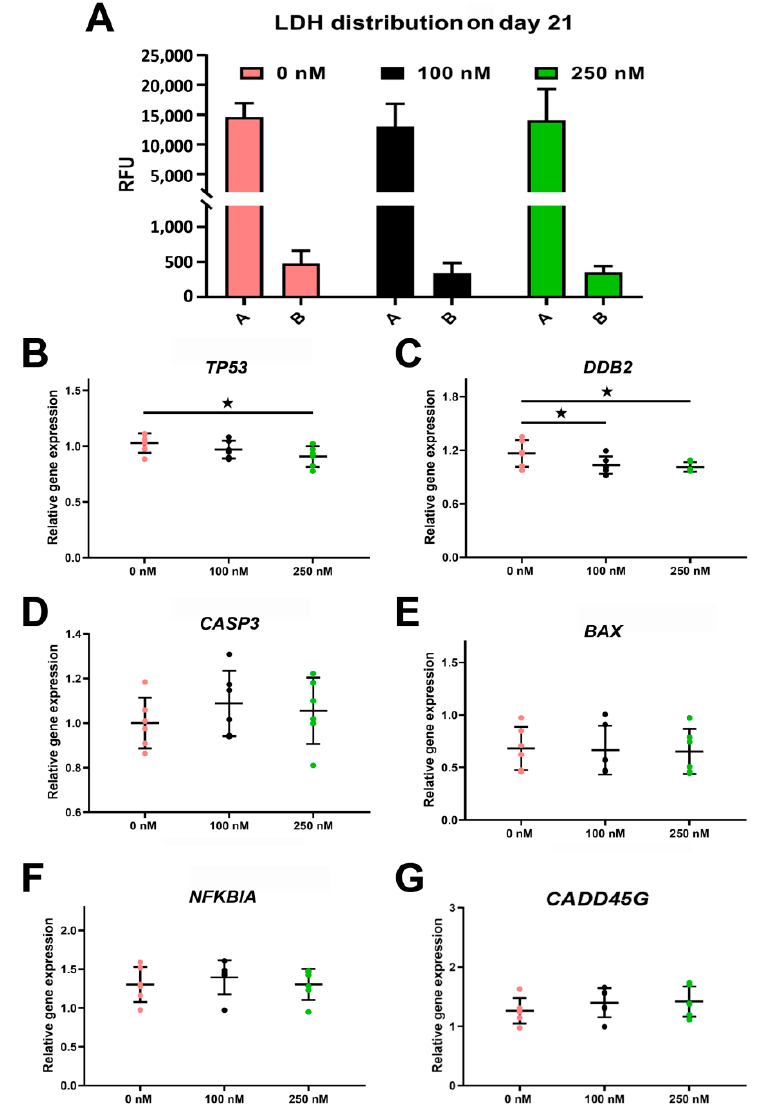
Figure 5. Apoptosis biomarkers in response to cortisol stimulation in ALI-POEC. ( A ) Constant lactate dehydrogenase (LDH) activity in apical and basal compartment. ( B – G ) Relative mRNA abundance of cell death marker genes. Data are shown as mean with SD. Asterisks indicate a significant difference at p < 0.05. n = six animals. Legend: RFU, relative fluorescence units.